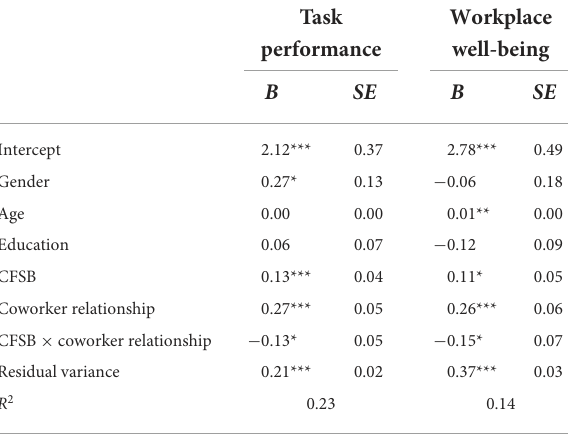
TABLE 4 Moderating effects of coworker relationship